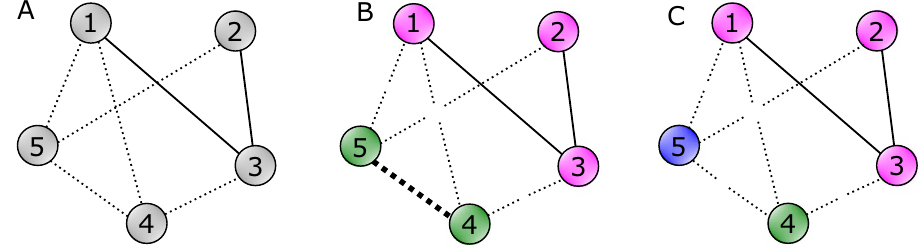
Figure 1. ( A ) An example signed network. ( B ) Evaluating classic balance via bi-partitioning involves finding the optimal 2-partition {{ 1, 2, 3 } , { 4, 5 }} and the edge (4, 5) which is frustrated under it. ( C ) Evaluating generalized balance and clusterability via k -partitioning leads to the optimal 3-partition {{ 1, 2, 3 } , { 4 } , { 5 }} which reduces the frustrated edges to